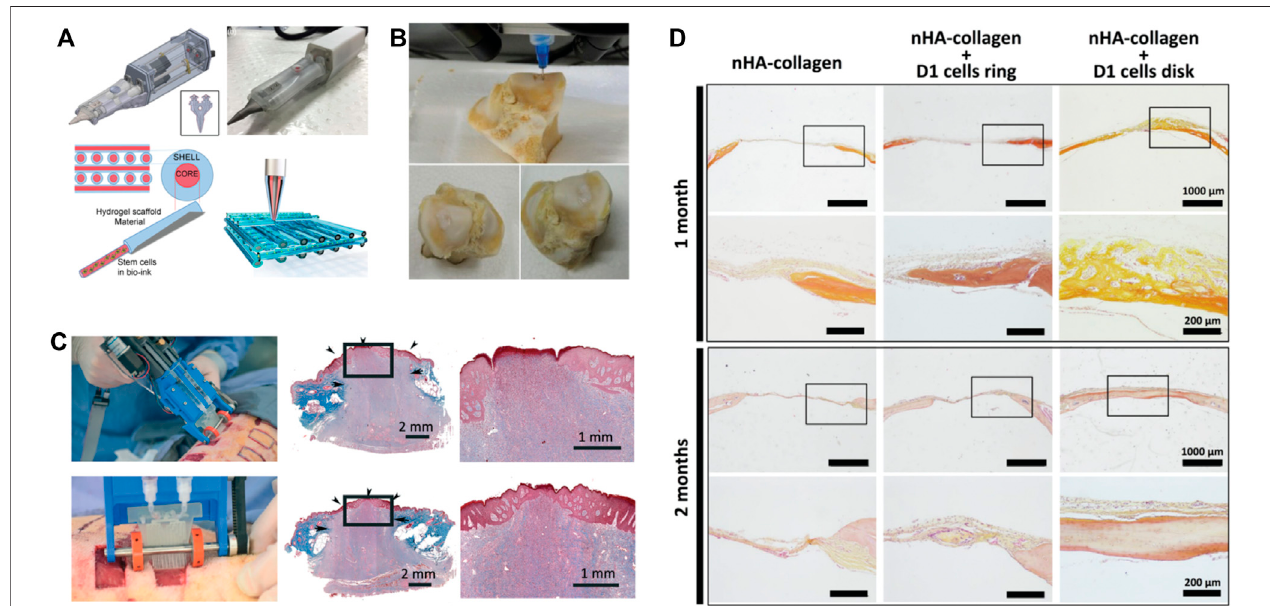
FIGURE 7 | (A) Design of the handheld Biopen to print gelatin methacrylamide and hyaluronic acid methacrylate (HA-GelMa) hydrogel scaffolds with core-shell structure. Reproduced with permission (di Bella et al., 2018). (B) In situ bioprinting to fabricate HA hydrogels for chondral defect repair. Reproduced with permission (Li et al., 2017). (C) In situ formation of fi brin-HA/collagen sheet for skin tissue regeneration. Reproduced with permission (Hakimi et al., 2018). (D) In situ bioprinting of mesenchymal stromal cells and nano-hydroxyapatite collagen for in vivo bone tissue regeneration. Reproduced with permission (Keriquel et al.,